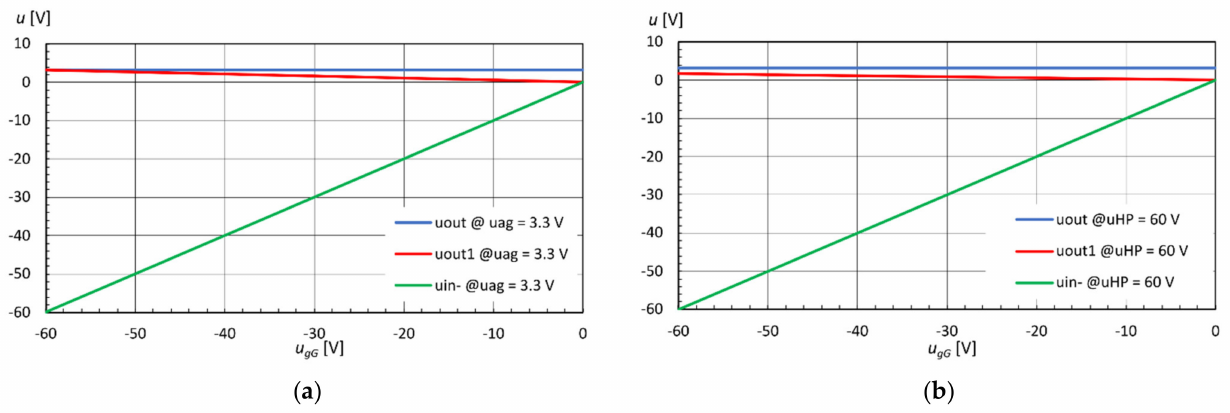
Figure 10. Two-stage circuit output u out and voltages at the second stage inputs vs. u gG for: ( a ) u ag = 3.3 V; ( b ) u HP = 60